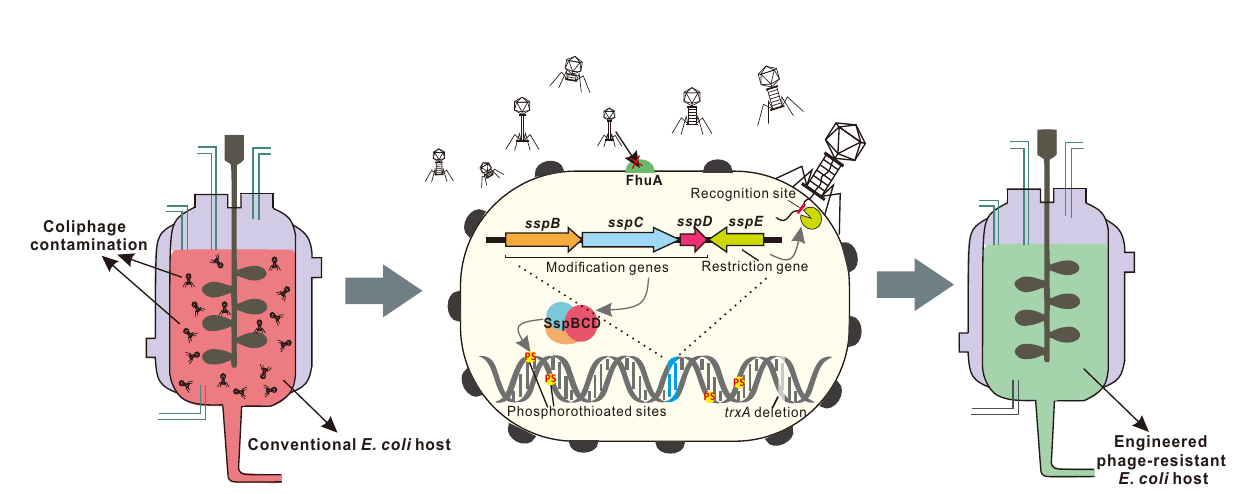
Fig. 4 Application of EPR E. coli strains in phage-rich fl ask-shaking or fed-bath recombinant protein production. a Flow chart of EPR E. coli strains applied in recombinant protein production. b - d Flask-shaking recombinant protein production characteristics of the wild-type and EPR E. coli strains when infected or not infected with phage cocktail. WT-MG1655 and MG1655-EPR strains producing DAAO ( b ), WT-W3110 and W3110-EPR strains producing DAAO ( c ), and WT-MG1655 (DE3) and MG1655 (DE3)-EPR strains producing nsp8 ( d ) are shown. Phage cocktail was added at the start of cultivation. Values represent the mean of three biological replicates, and error bars represent standard deviations (dots). Statistical signi fi cance was calculated by one- way ANOVA followed by Tukey ’ s test. ns, not signi fi cant. e – g Average fed-batch fermentation pro fi le of the wild-type and EPR E. coli strains when infected or not infected with phage cocktail. WT-MG1655 and MG1655-EPR strains producing DAAO ( e ), WT-W3110 and W3110-EPR strains producing DAAO ( f ), and WT-MG1655 (DE3) and MG1655 (DE3)-EPR strains producing nsp8 ( g ) are shown. Phage cocktail was added at the start of fermentation (black arrow), and IPTG was added when the OD 600 reached 20 (red arrow). Values represent the means of duplicate fermentation pro fi les. Source data are provided as a Source Data fi le.